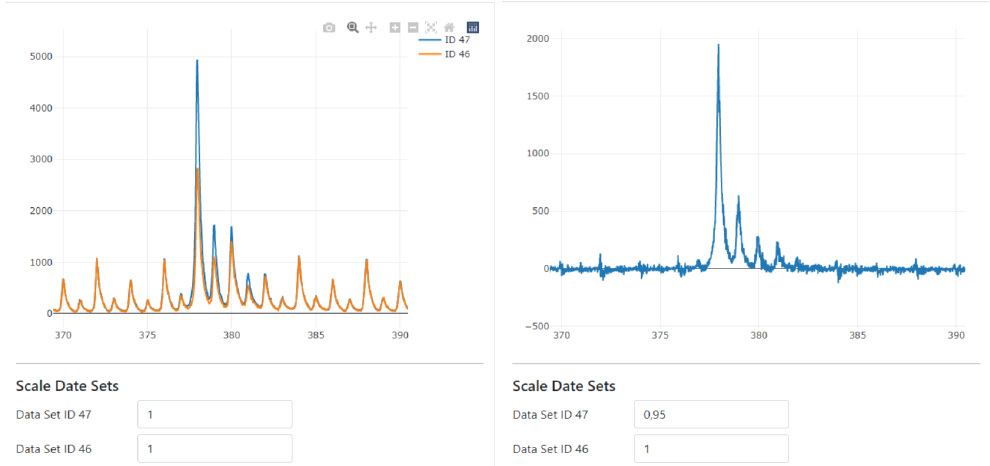
Figure 2. Detailed view of the data representation. Left: comparison of two mass spectra plotted on top of each other with a linear y-axis. Right: difference between the same two mass spectra, with a scaling factor of 0.95 applied to the first mass